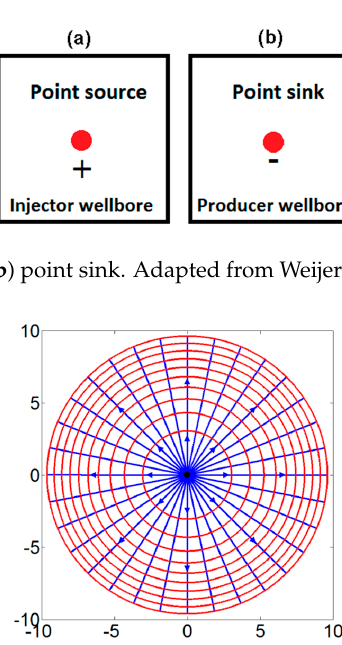
Figure 3. Point source injection with associated streamlines (blue) and time-of-flight (TOF) contours (red) spaced for 1 year; total TOF is 10 years. Parameters: z c = 0 + 0 × 1 i, q ( t ) = 1.84 × 10 − 7 m 3 /s, h = 1 m, n = 0.2, and Δ t = 0.1 day. After Van Harmelen and Weijermars [9].